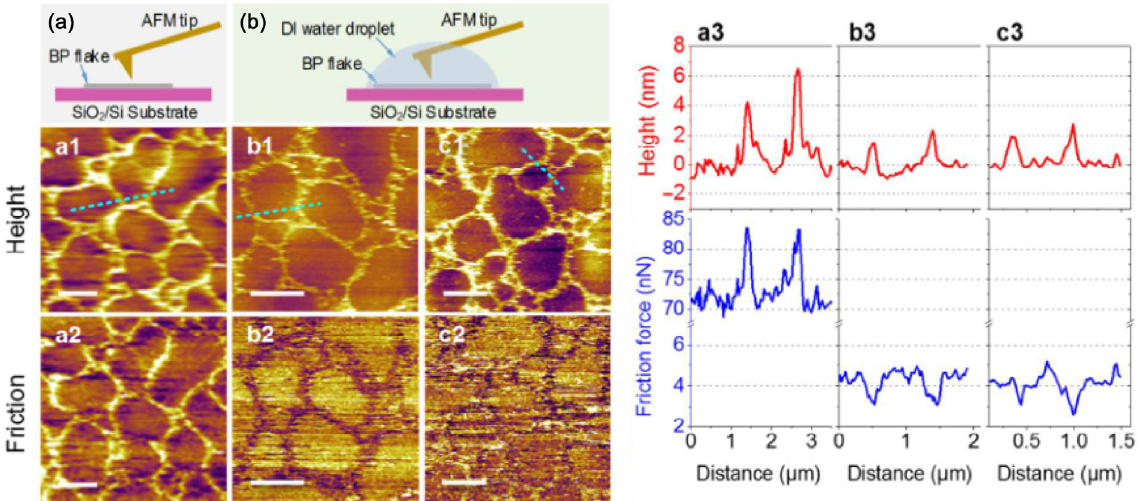
Fig. 13 Degradation of BP nanosheets favored the lubrication properties. Reproduced with permission from Ref. [146]. © American Chemical Soeity,